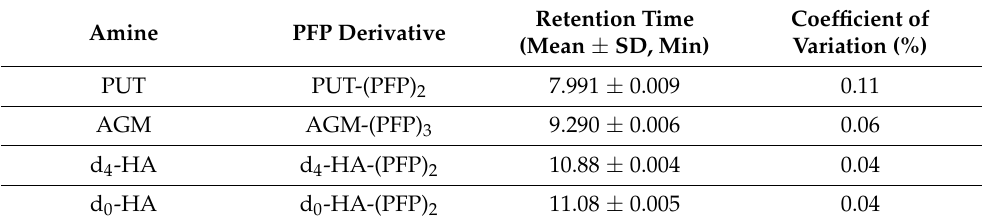
Table 2. Summary of the retention times of the PFP derivatives of the indicated amines from their aqueous buffered solutions using ethyl acetate and the starting oven temperature of 40 ◦ C (each n =